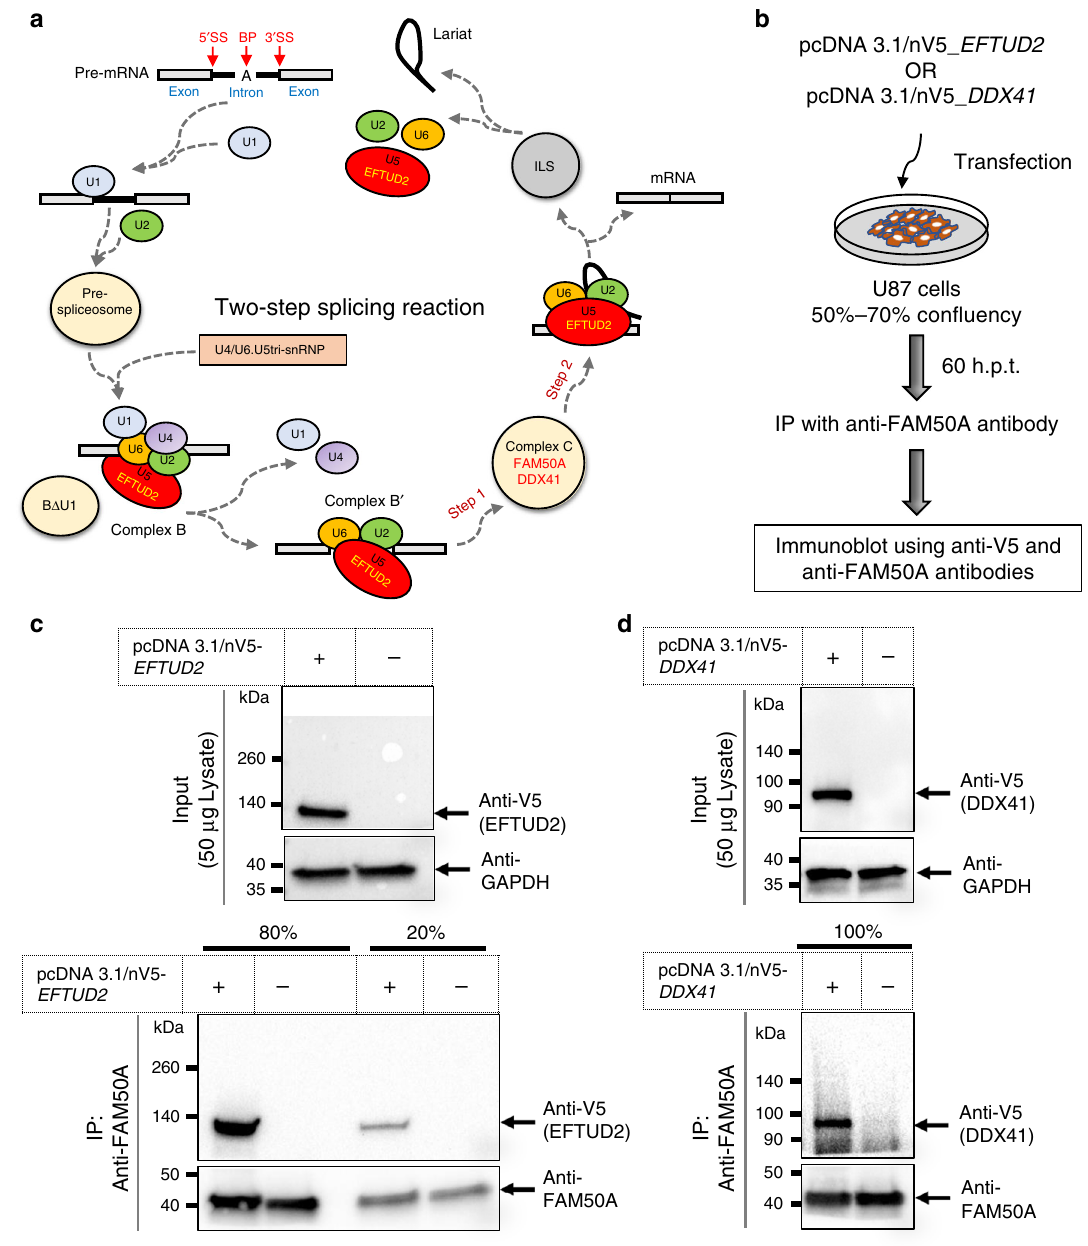
Fig. 6 FAM50A interacts with U5 and C-complex proteins. a Schematic representation of the two-step splicing reaction (adapted from ref. 70 ). EFTUD2 (U5); FAM50A and DDX41 (C-complex). b Graphical representation of semi-native co-immunoprecipitation assay. Candidate interactors were overexpressed in U-87 cells, harvested in immunoprecipitation (IP) lysis buffer at 60 h post-transfection and immunoprecipitated with anti-FAM50A antibody. The interaction partners were detected in IP lysate using anti-V5 and anti-FAM50A antibodies, respectively. c , d Western blot of proteins after co-immunoprecipitation. Top: total protein lysate input (50 μ g/lane) was migrated on 4 – 15% polyacrylamide gels to detect EFTUD2 ( c ) or DDX41 ( d ) using anti-V5 mouse monoclonal antibody. GAPDH was used as loading control. Bottom: Anti-FAM50A antibody was used to immunoprecipitate native FAM50A protein in total input lysate of 2.3 mg/condition ( c ) or 3.5 mg/condition ( d ). The IP lysate was separated in two parts (20% and 80%) and migrated independently on 4 – 15% polyacrylamide gels. The proteins of interest with predicated band sizes are indicated with black arrows. Plus and minus signs indicate presence and absence of relevant plasmids, respectively. EFTUD2 and DDX41 were detected in independent experiments using protein lysates derived from replicate batches of U-87